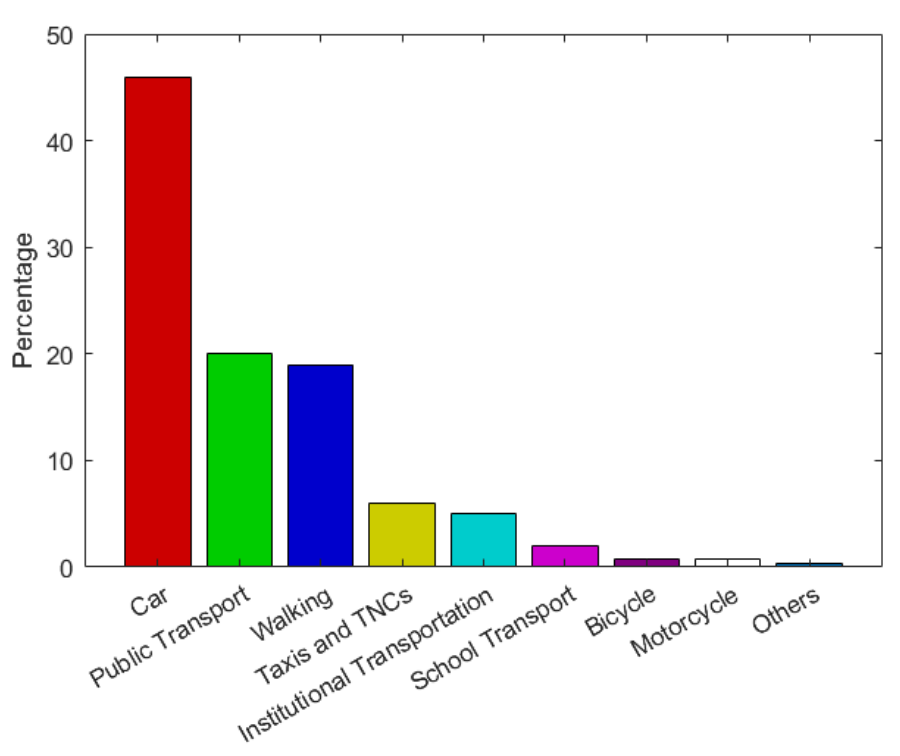
Figure 1. Mode share of the MMA. Source: